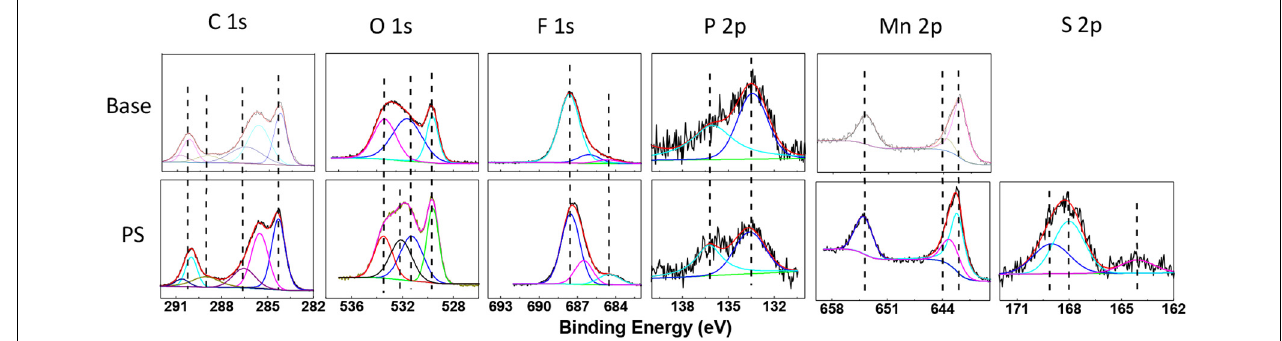
FIGURE 10 | XPS spectra of C 1s, O 1s, F 1s, P 2p, Mn 2p, and S 2p for the LiMn 2 O 4 electrodes after 180 cycles at 60 ◦ C in base electrolyte and PS-containing electrolyte.